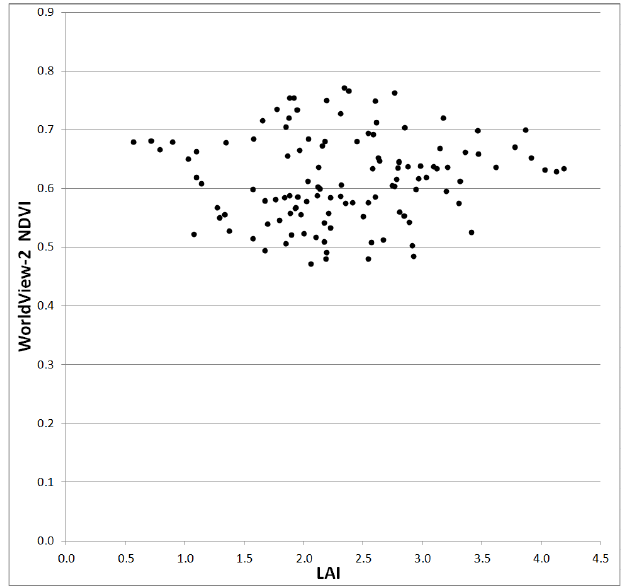
Figure 11. WorldView-2 Normalized Difference Vegetation Index (NDVI) versus LAI for n = 122